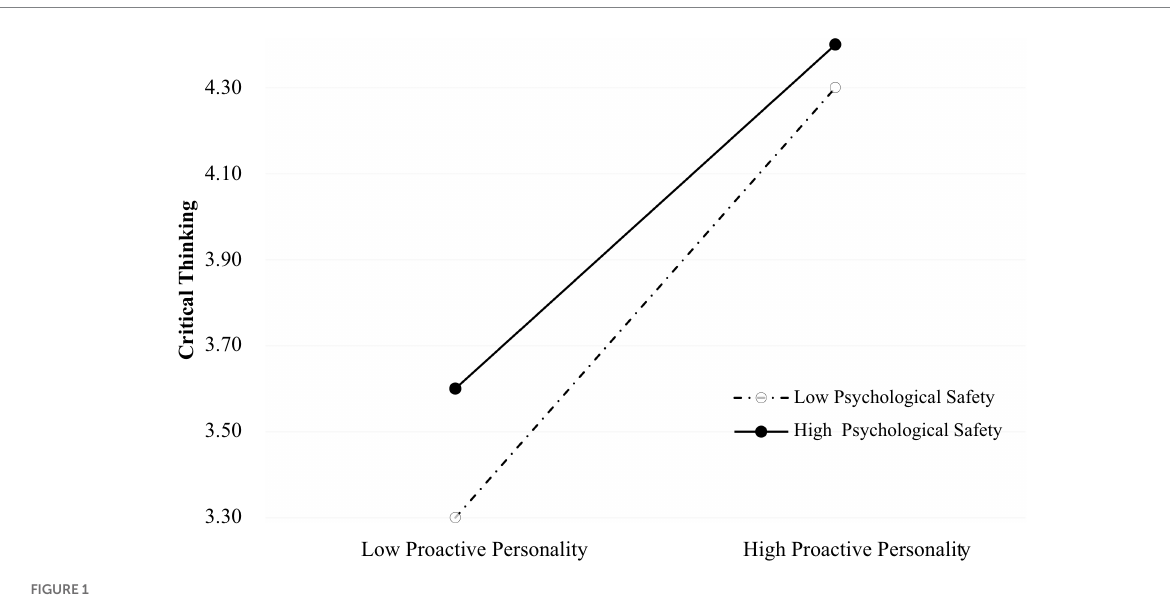
FIGURE 1 Simple slope plot of the interaction between proactive personality and psychological safety on critical thinking.